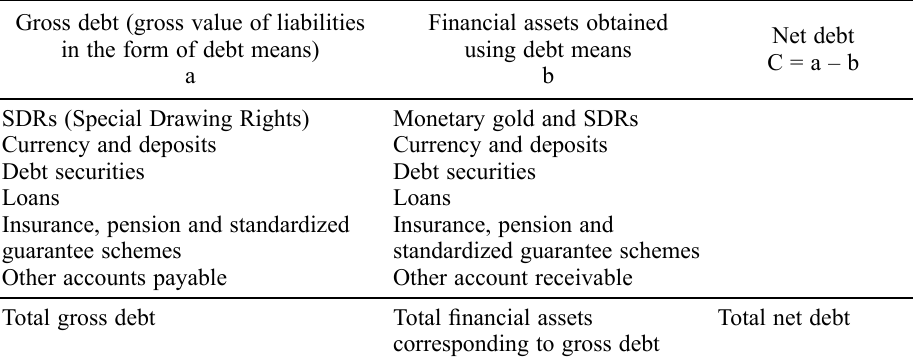
Table 1. Calculation of net